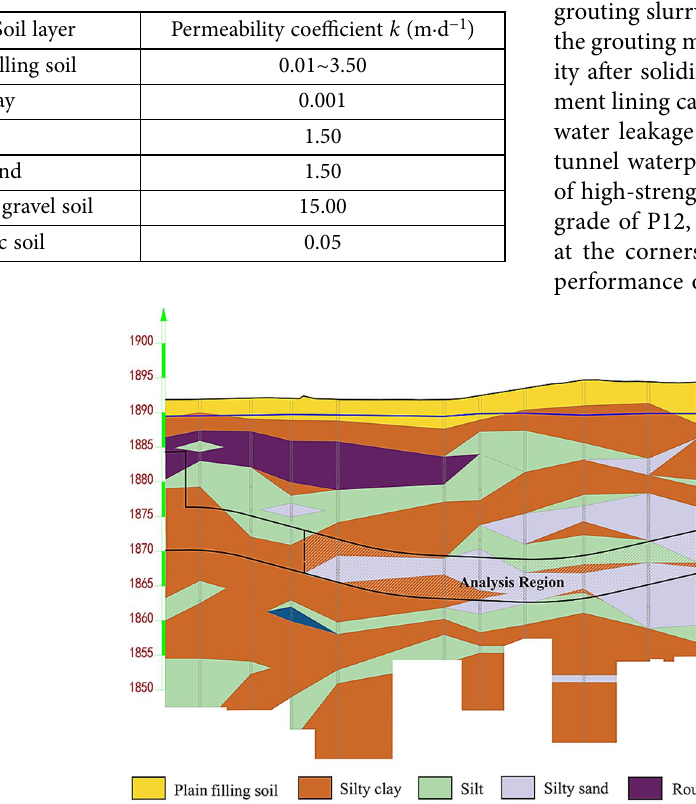
Table 17. Permeability coefficient of soil layers